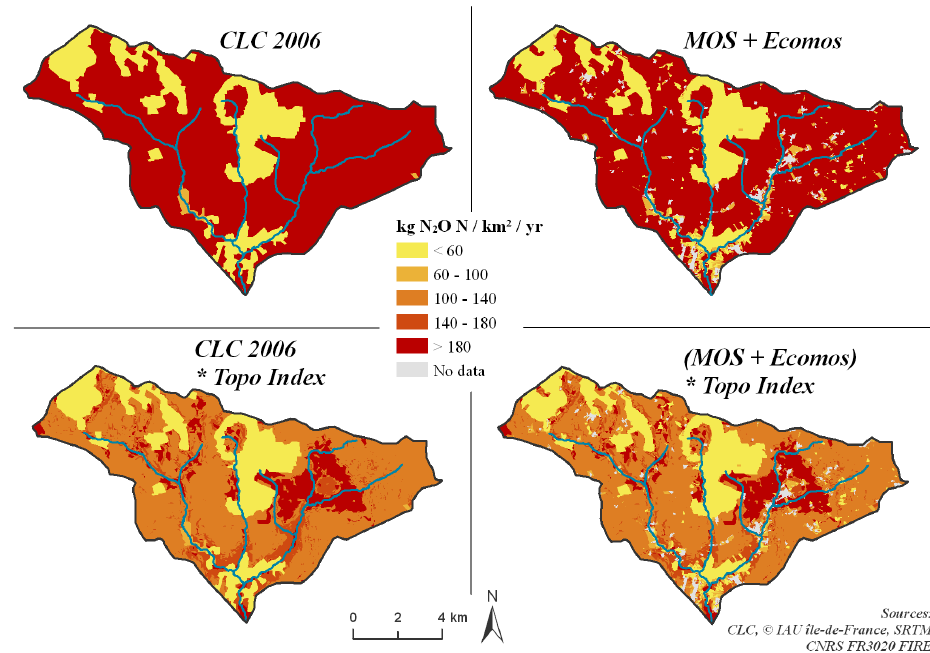
Fig. 6. Estimation of nitrous oxide emissions as a function of the land cover database and the topography.